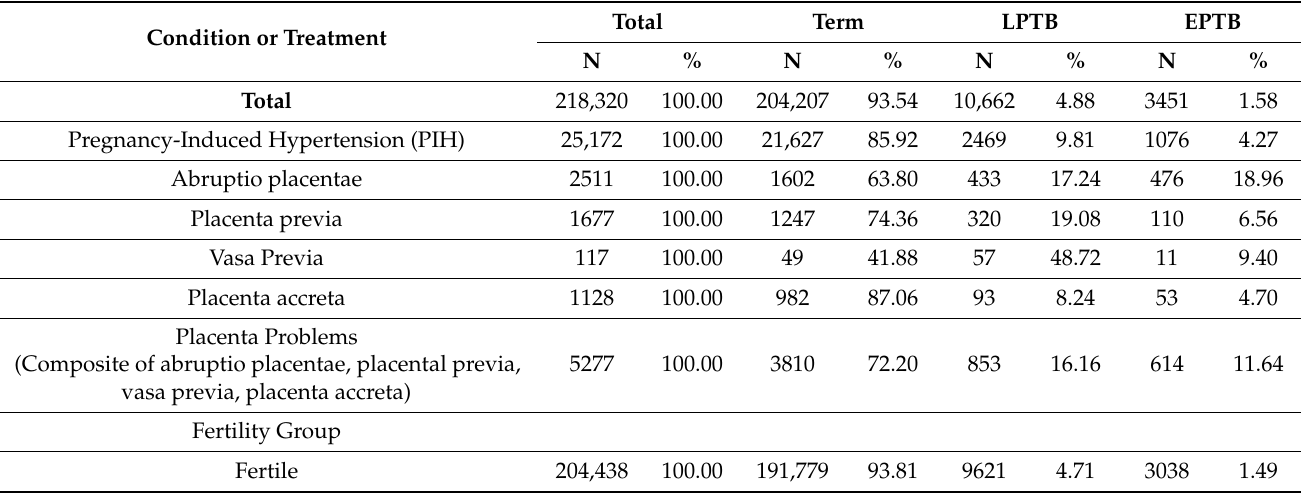
Table 1. Term, late preterm and early preterm delivery in deliveries with placental problems and PIH and in fertile, ART-treated and ART